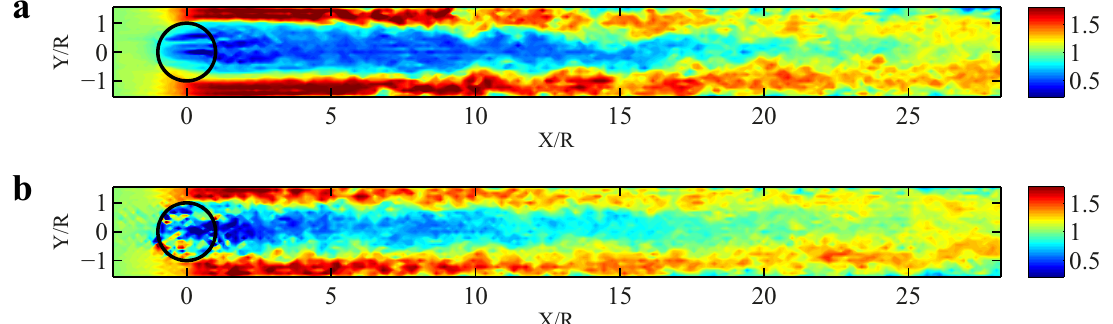
Figure 14. Contours of the normalized instantaneous streamwise velocity, u/U horizontal plane at the equator height of the rotor for the two turbine models: ( a ) actuator swept surface model; ( b ) actuator line model. In both contour plots, the MGM is used.